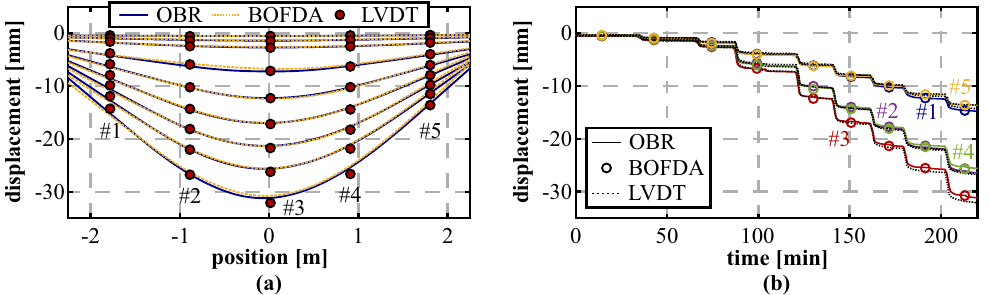
Figure 20. Analysis of different sensing techniques during vertical loading from 50 kN to 450 kN (steps of 50 kN): ( a ) Displacement curves calculated from OBR and BOFDA measurements compared to pointwise LVDT readings. ( b ) Displacements at LVDT locations over